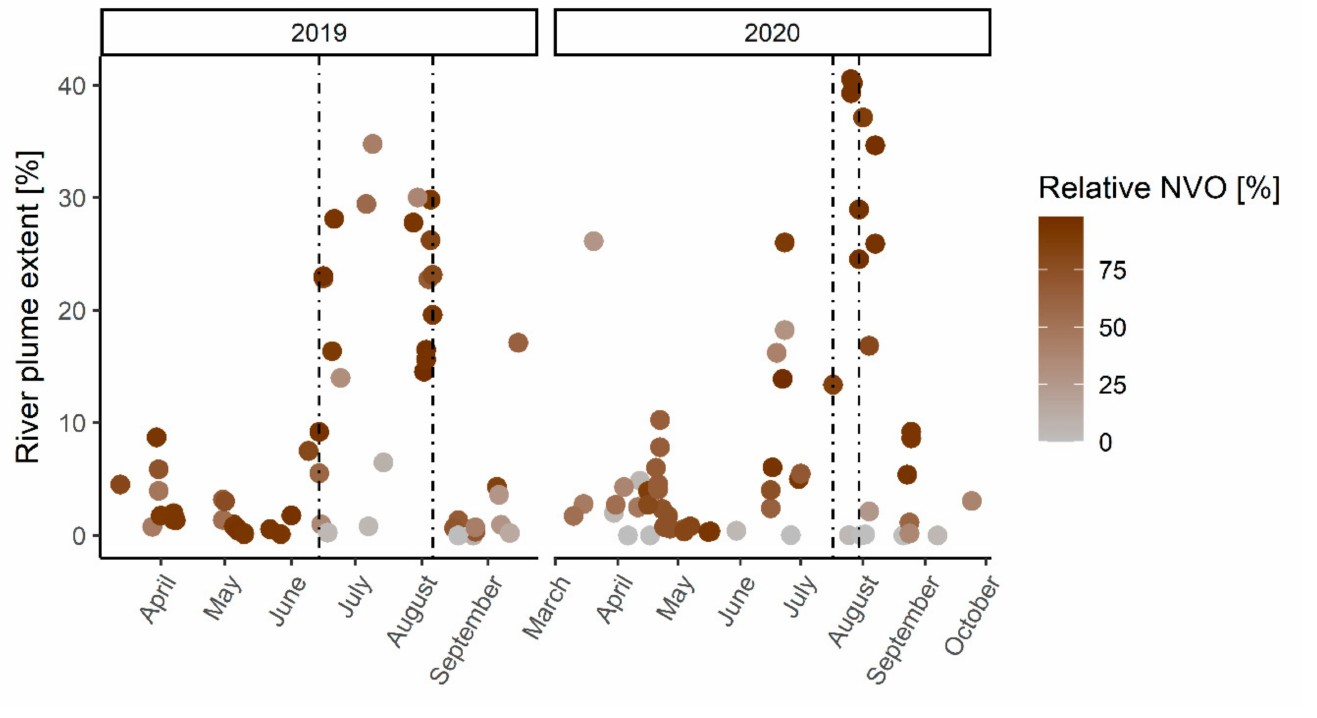
Figure 3. Relative area of Adventfjorden classified as river plume (i.e., covered by C SPM 30 to 500 mg L − 1 ). Cloud cover as estimated from the relative number of valid observations (NVO) per day is shown as the gradient of colour. Images in JJA with extensive (>50%) cloud cover, i.e., invalid observations, were excluded from the environmental statistics later on. Dashed lines represent the in-situ matchup days considered for the cal/val dataset.